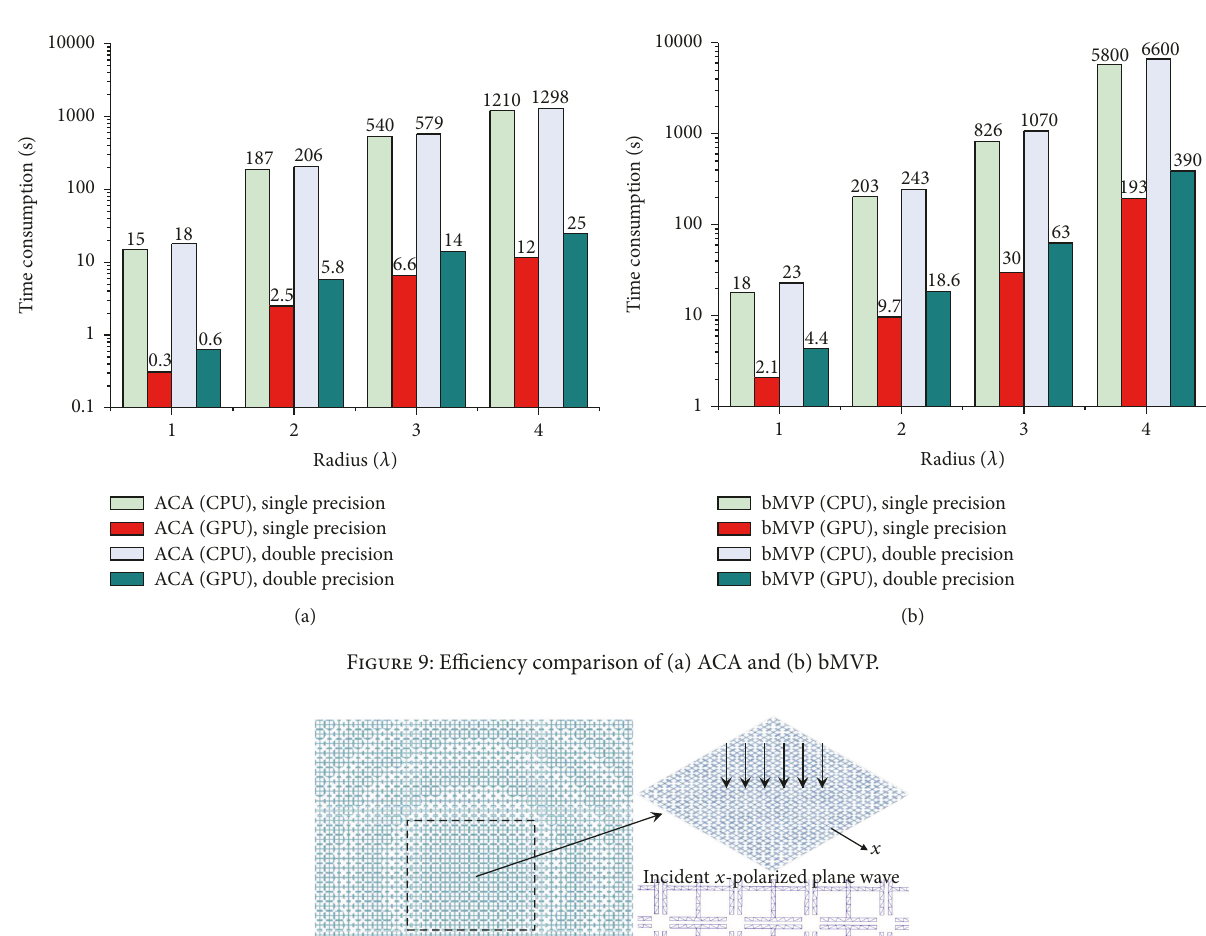
Figure 8: Bistatic RCS of (a) 4 blades rotor and (b) depressed cylindrical object.